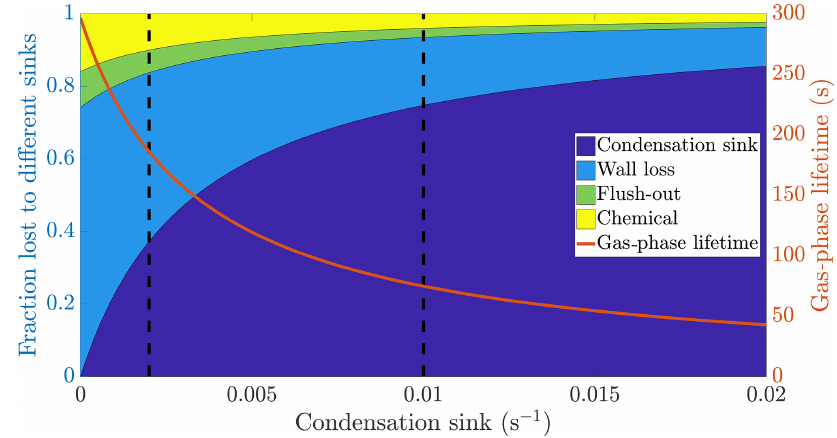
Figure 1. The calculated fraction of ELVOC lost to different sinks, and their total lifetime in the gas phase as a function of the condensation sink caused by aerosol particles in the chamber. The wall loss lifetime of ELVOC is estimated to be 400s. The chemical loss is an upper limit estimate, based on an OH concentration of around 0.1ppt and collision limited reaction with ELVOC. The vertical broken lines at 0.002 and 0.01s − 1 represent a typical situation without seed particles and with seed particles respectively (Table